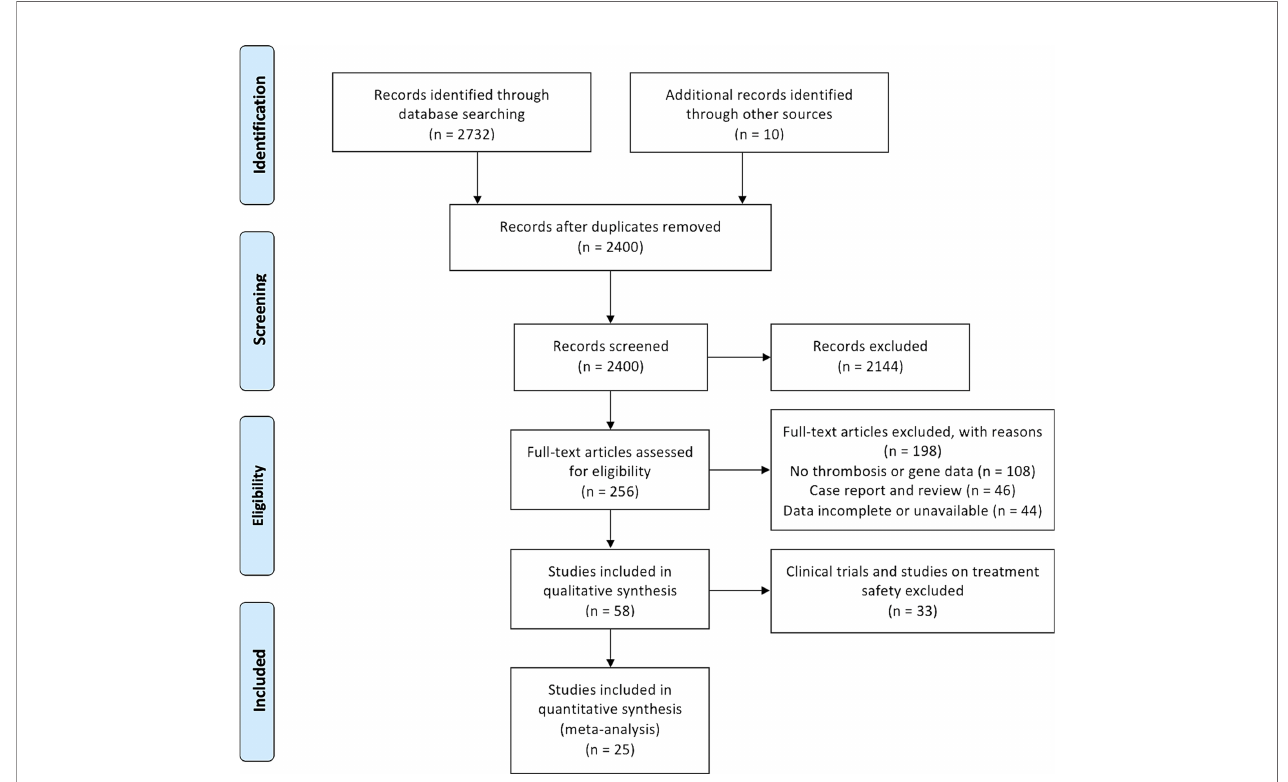
FIGURE 1 | PRISMA fl ow